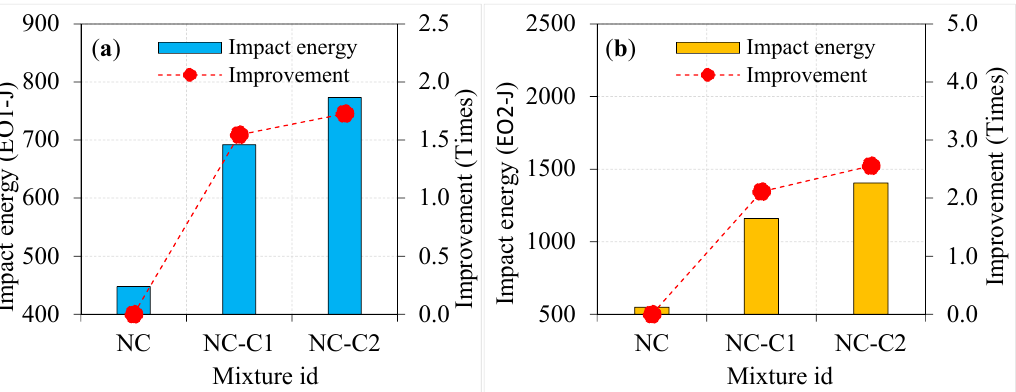
Figure 10. Effect of asphalt coating on impact strength of non-fibrous specimens ( a ) EO1 and ( b ) EO2.